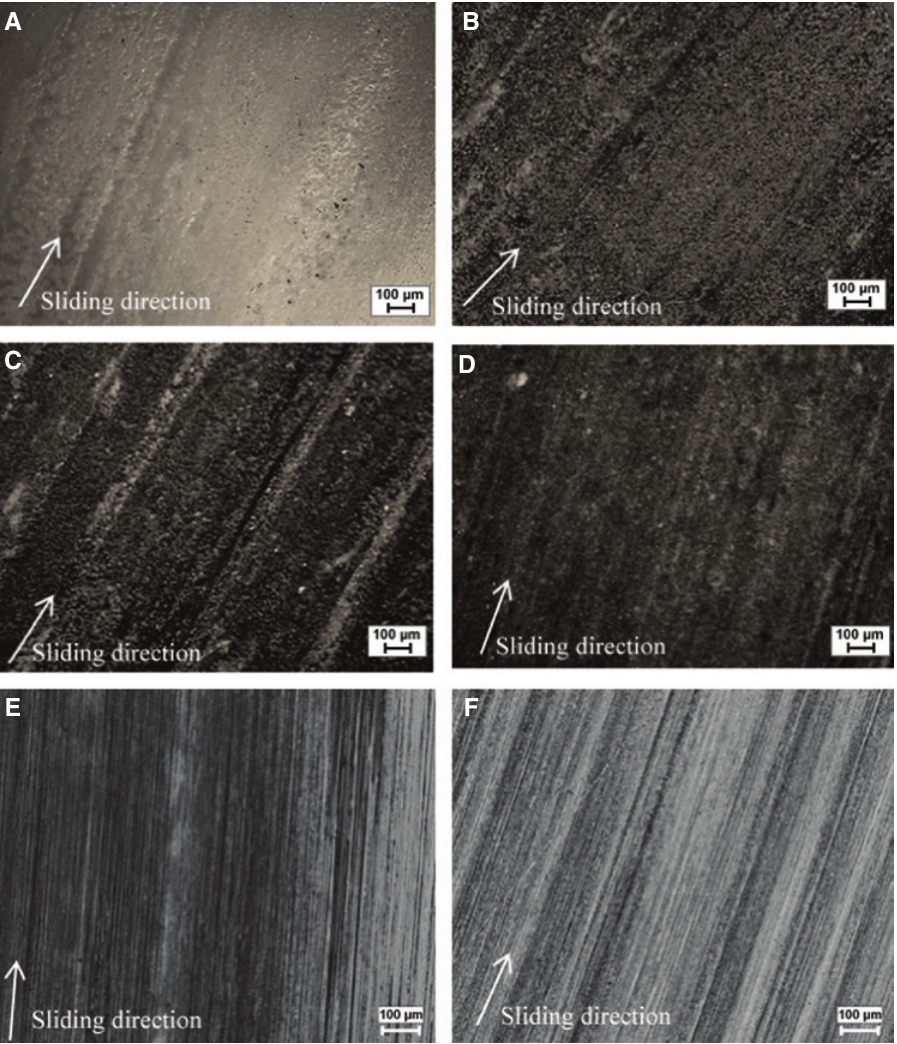
Figure 8: Optical micrographs of worn pin and disc surfaces of fly ash epoxy composites at 0.4 m/s sliding speed and 15 N load conditions. (A) Worn pin surface of pure epoxy, (B) worn pin surface of 10 wt% fly ash-filled epoxy composite, (C) worn pin surface of 20 wt% fly ash- filled epoxy composite, (D) worn pin surface of 30 wt% fly ash-filled epoxy composite, (E) worn disc surface of pure epoxy, and (F) worn disc surface of 30 wt% fly ash-filled epoxy